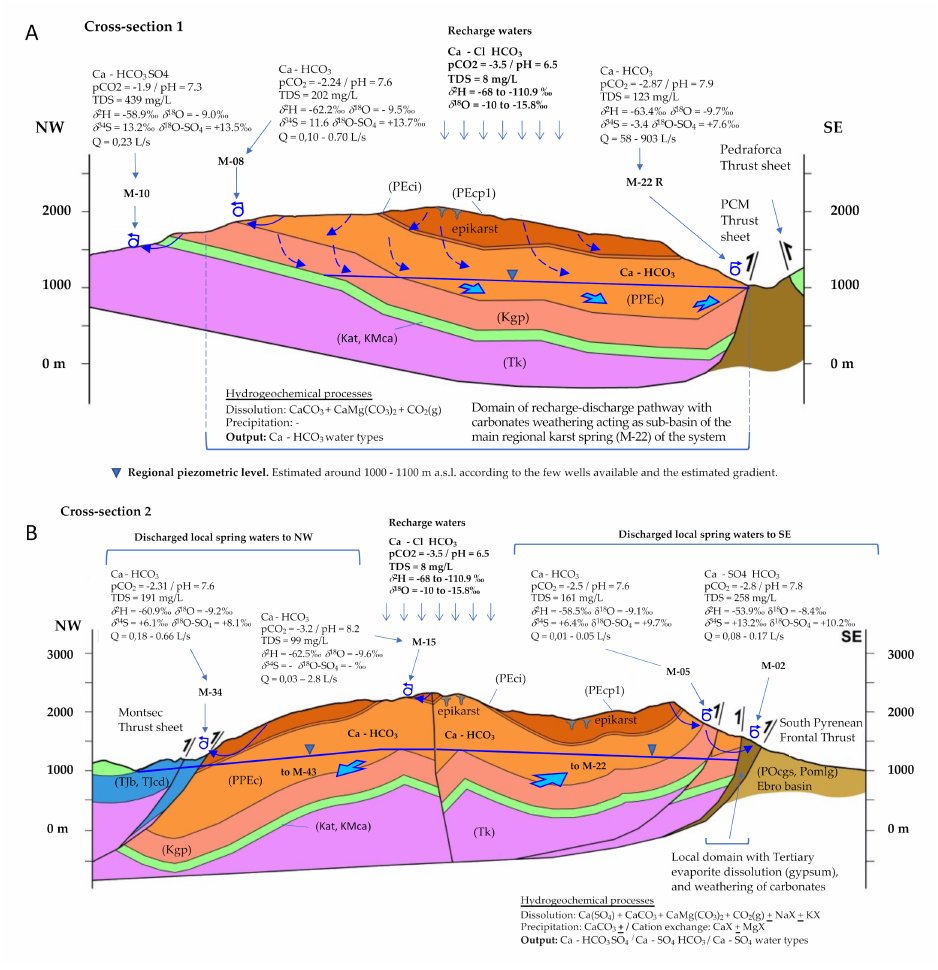
Figure 13. Hydrogeological-hydrogeochemical conceptual models of ( A ) cross-section 1 and ( B ) cross-section 2. The sketch includes different water springs projected close to the cross-section. The situation of the cross-sections is shown in Figure